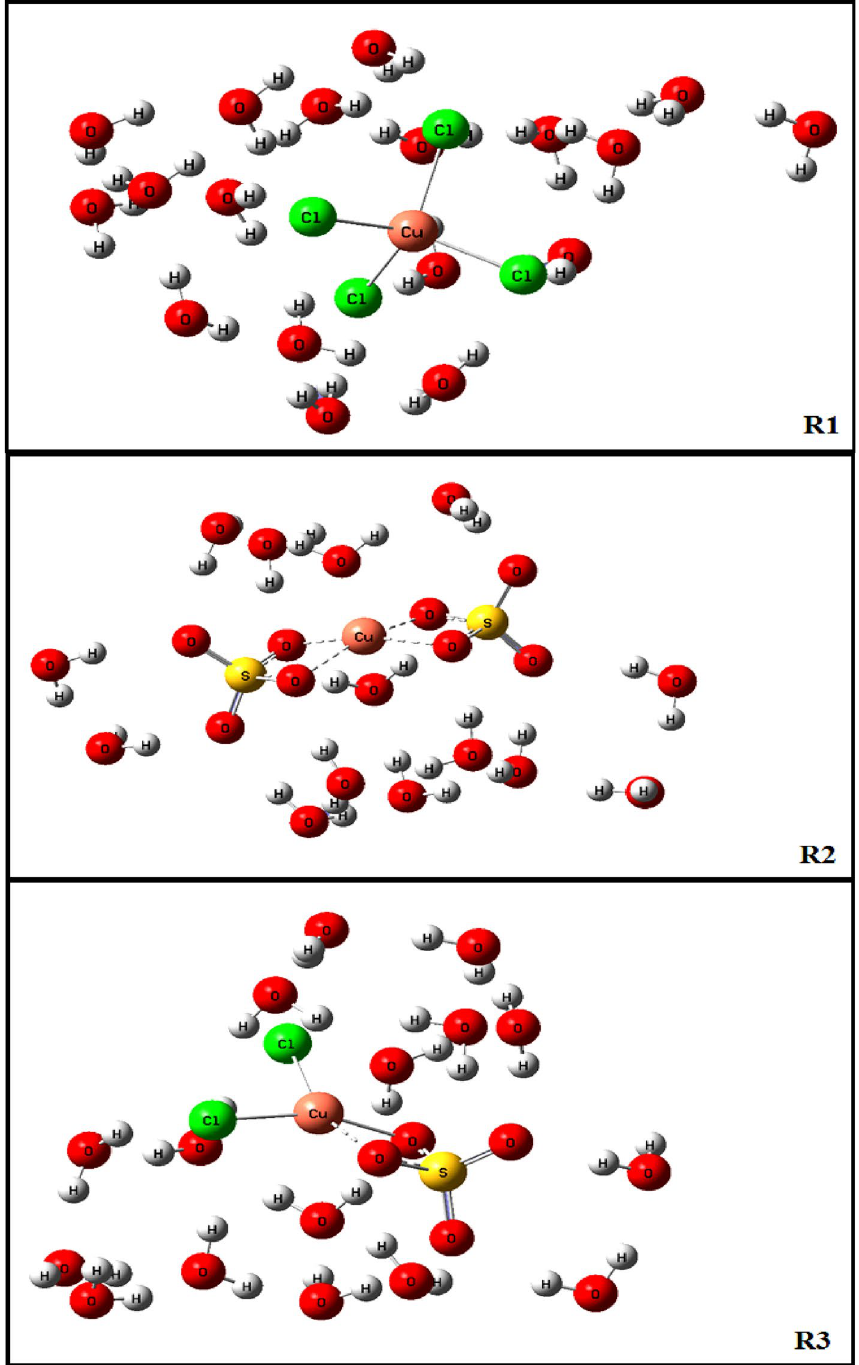
Figure 13. The structures of the species involved in the reactions R1, R2 and